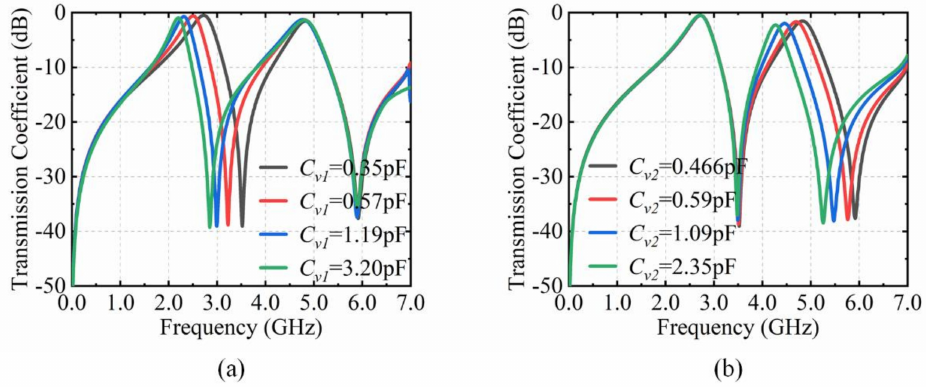
Figure 3. CST simulation results of the proposed structure. ( a ) Transmission coefficient with C v 1 from 0.35 pF to 3.20 pF. ( b ) Transmission coefficients with C v 2 from 0.466 pF to 2.35